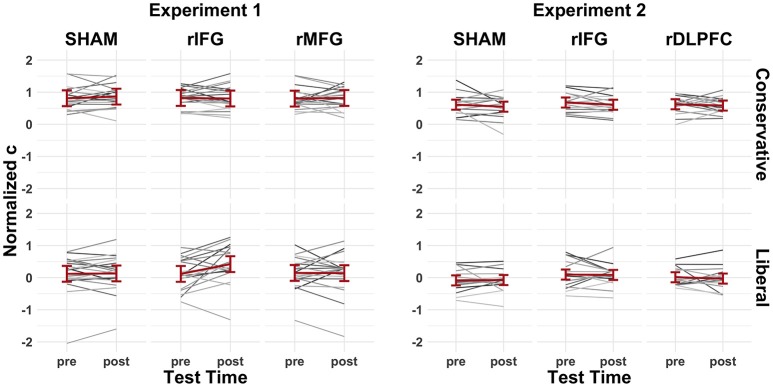
The pre-/post-cTBS normalized c values for Experiment 1 (left) and Experiment 2 (right). Gray lines indicate individual subject performance and red lines represent group averages fitted with 95% confidence intervals.